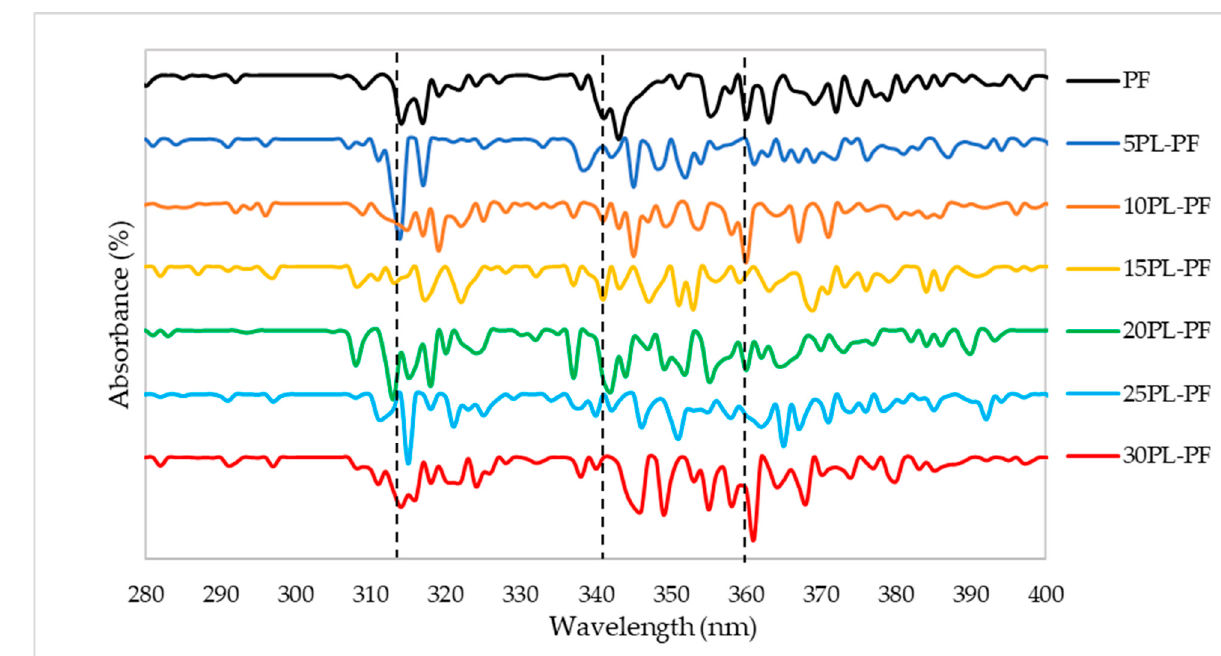
Polymers 2023 , 15 , x FOR PEER REVIEW Figure 3. UV spectrum of the PL − PF resins from 5 to 30% phenol substitution rate.